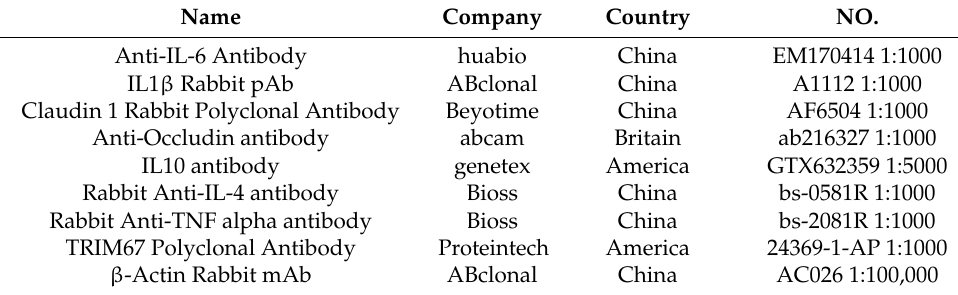
Table 3. Antibodies were used in this